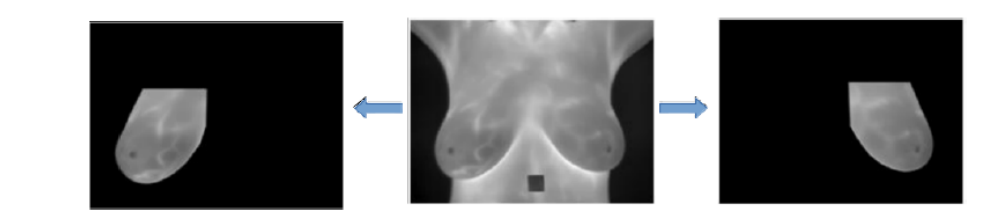
Figure 4. Result of the Region of Interest (ROI) segmentation. Copyright c (cid:13) 2019 IEEE, all rights reserved.